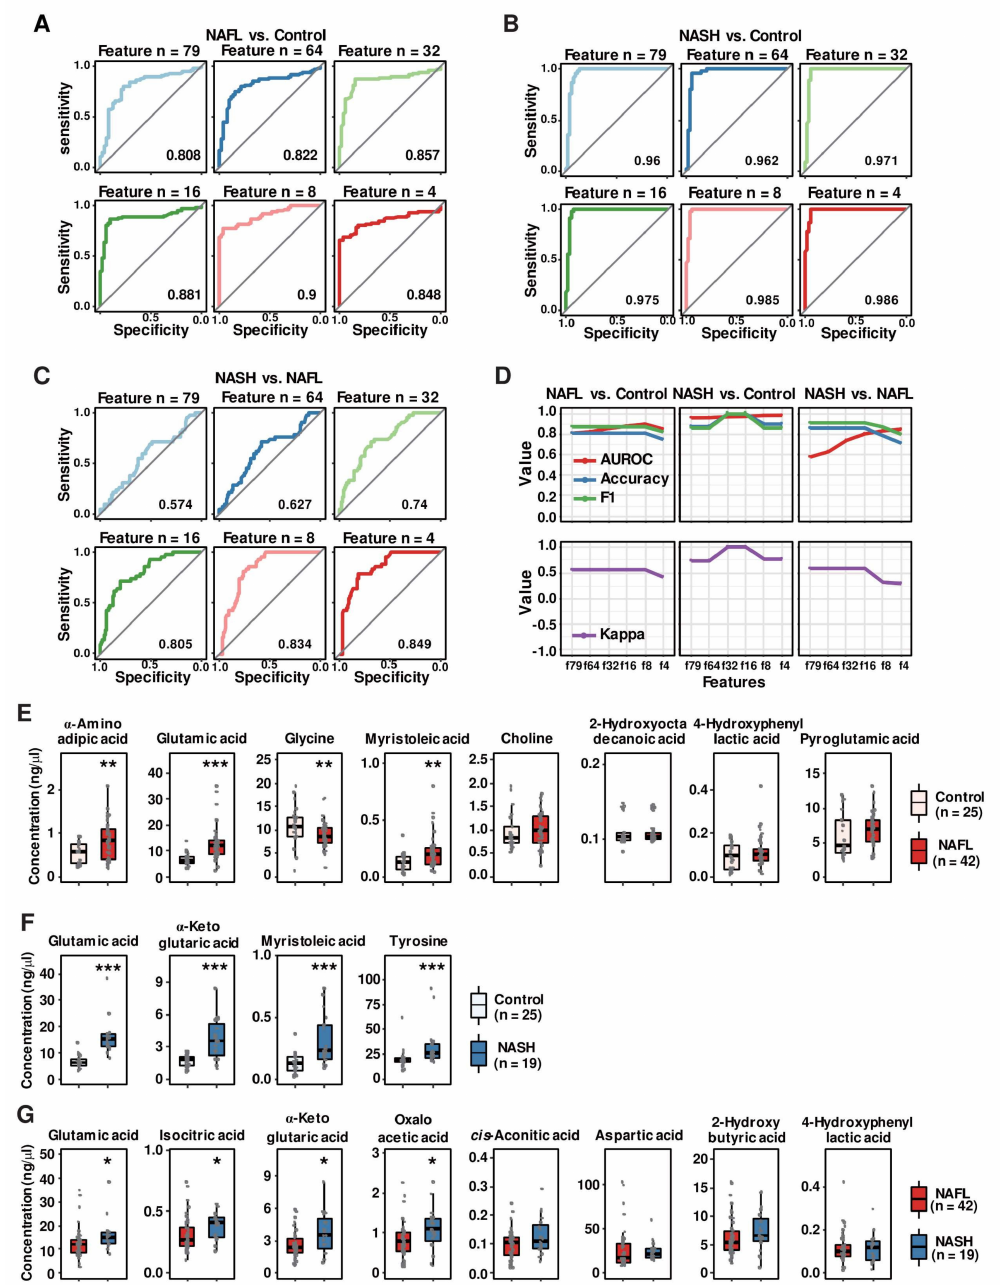
Figure 3. Predictive power of RF classification models and the comparison of metabolite abundances of RF-featured metabolites between groups. ( A – C ) AUROC curves of RF classification models for distinguishing the study groups: ( A ) NAFL vs. control; ( B ) NASH vs. control; and ( C ) NASH vs. control. ( D ) The predictive power of the classification models evaluated by AUROC curves, accuracies, F1-scores, and kappa values. ( E – G ) Boxplots showing the abundance of RF-featured classifier metabolites: ( E ) NAFL vs. control classifiers; ( F ) NASH vs. control classifiers; and ( G ) NASH vs. NAFL classifiers. Each scatter dot in the boxplots represents the concentration of each subject. The Wilcoxon rank sum test was used to determine significant differences between two groups. *, p < 0.05; **, p < 0.01; and ***, p < 0.001 between